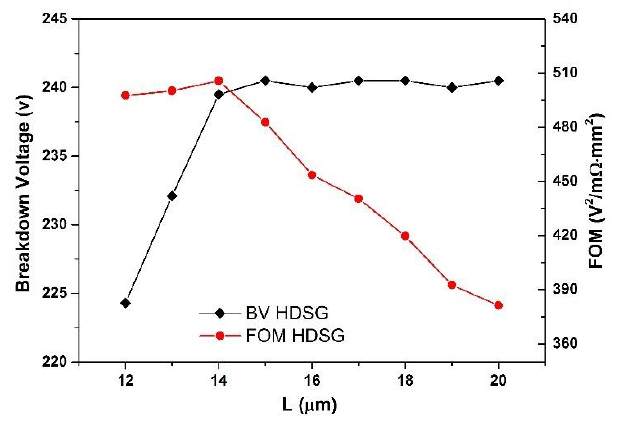
Figure 7. BV and FOM (BV 2 / R SP ) of HDSGRSO UMOSFET at different n-drift region thickness.